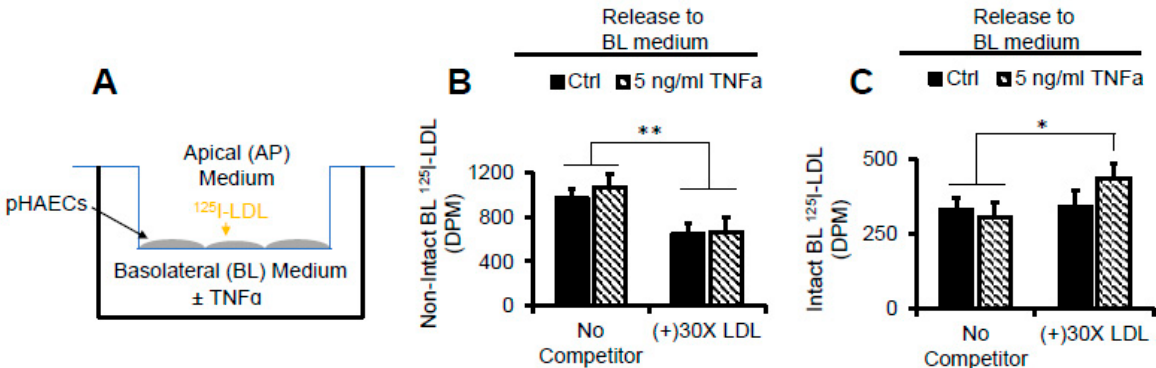
Figure 11. TNF α does not affect AP to BL release of degraded LDL protein. ( A ) Diagram of the experimental setup in ( B , C )